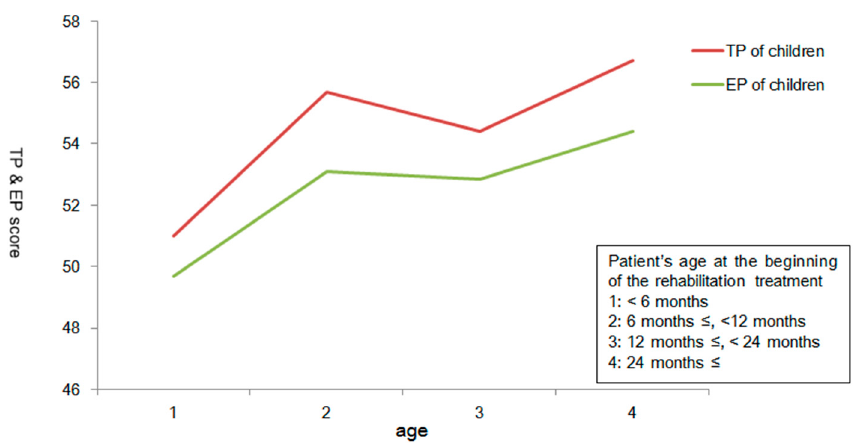
Figure 1. The relationship between the timing of rehabilitation and child’s stress level. EP: the externalizing problems are obtained by combining attention problems and aggressive behavior. TP: the total problems score is obtained by combining all eight